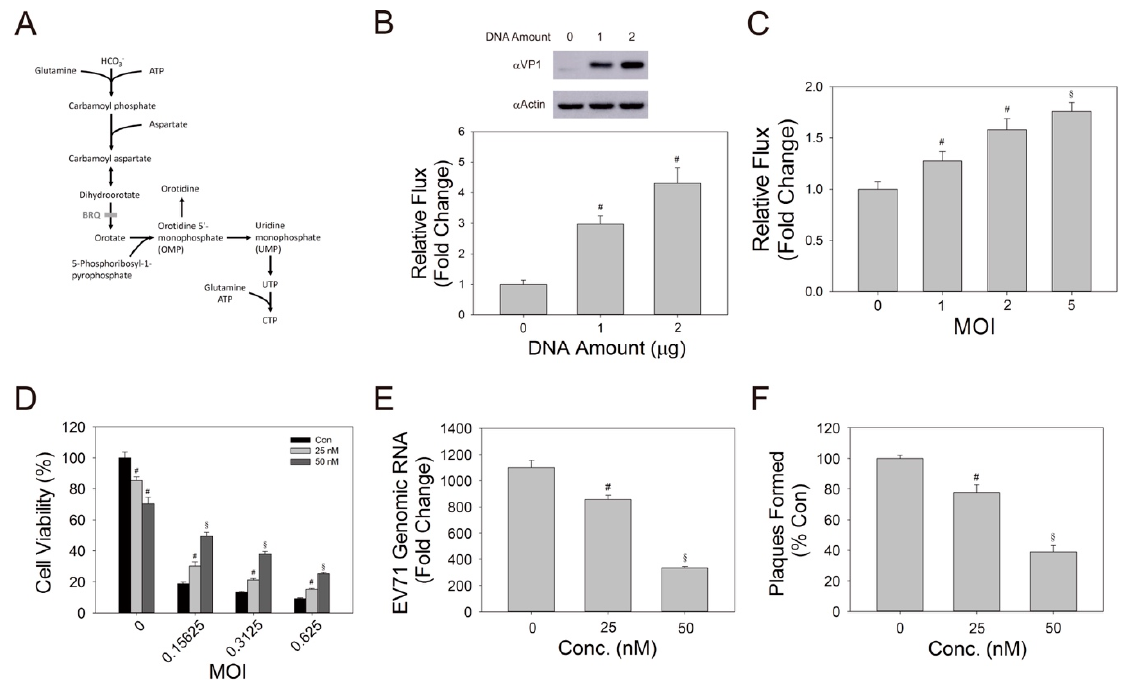
Figure 9. VP1 expression promotes pyrimidine biosynthesis that is essential to viral replication. ( A ) A simplified diagram shows the de novo pyrimidine biosynthesis pathway. It is noted that BRQ selectively inhibits DHODH. ( B ) (Upper panel) Vero cells were transfected with 0, 1, or 2 µ g of VP1 expression vector (plus empty expression vector to maintain the total amount of transfected DNA at 2 µ g). Twenty-four hours later, cells were harvested for western blotting with anti-VP1 antibody ( α VP1) or anti-actin ( α Actin) antibodies. A representative result of three experiments is shown. (Lower panel) Vero cells were transfected in a similar manner. Twenty hours later, cells were labeled in NaH 13 CO 3 -containing medium and treated with BRQ as described in Materials and Methods. The cell extracts were subjected to mass spectrometric analysis. The abundance of [ 13 C]-dihydroorotate ( m / z 158.0283) was quantified from the corresponding extracted ion chromatogram and divided by the labeling time, and the flux is expressed as fold change relative to that of mock-transfected cells. Data are mean ± SD of six replicates. # p < 0.05, significant difference from the mock-transfected cells. ( C ) Vero cells were infected with EV71 at MOIs of 1, 2 and 5, labeled in NaH 13 CO 3 -containing medium, and treated with BRQ, as described in Materials and Methods. The abundance of [ 13 C]-dihydroorotate was quantified and divided by the labeling time, and the flux is expressed as fold change relative to that of mock-infected cells. Data are mean ± SD of six replicates. # p < 0.05, § p < 0.01, significant difference from the mock-infected cells. ( D ) Vero cells were mock- or infected with EV71 at the indicated MOIs for 1 h, and treated with 25 or 50 nM BRQ till 48 h p.i. The cell viability was assayed, as described above. The data are expressed as percentage relative to those of the untreated mock-infected cells, and presented as mean ± SD of six separate experiments. # p < 0.05, § p < 0.01, significant difference from the untreated cells (Con). ( E ) Vero cells were mock- or infected with EV71 at MOI of 0.3125 for 1 h, and treated with 25 or 50 nM BRQ till 30 h p.i. Total RNA was extracted for quantification of genomic RNA. The result is expressed as fold change relative to that at 0 h p. i. The data are presented as mean ± SD of six separate experiments. # p < 0.05, § p < 0.01, significant difference from the untreated cells. ( F ) Vero cells were infected with EV71 for 1 h, and were overlaid with 0.3% agarose in MEM/2% FCS, which was supplemented with 25 or 50 nM BRQ. The infected cells were processed for crystal violet staining as described in Materials and Methods. The number of plaques was counted, and is expressed as percentage relative to that formed in the absence of BRQ. Data are mean ± SD of six experiments. # p < 0.05, § p < 0.01, significant difference from that formed in the control plates.